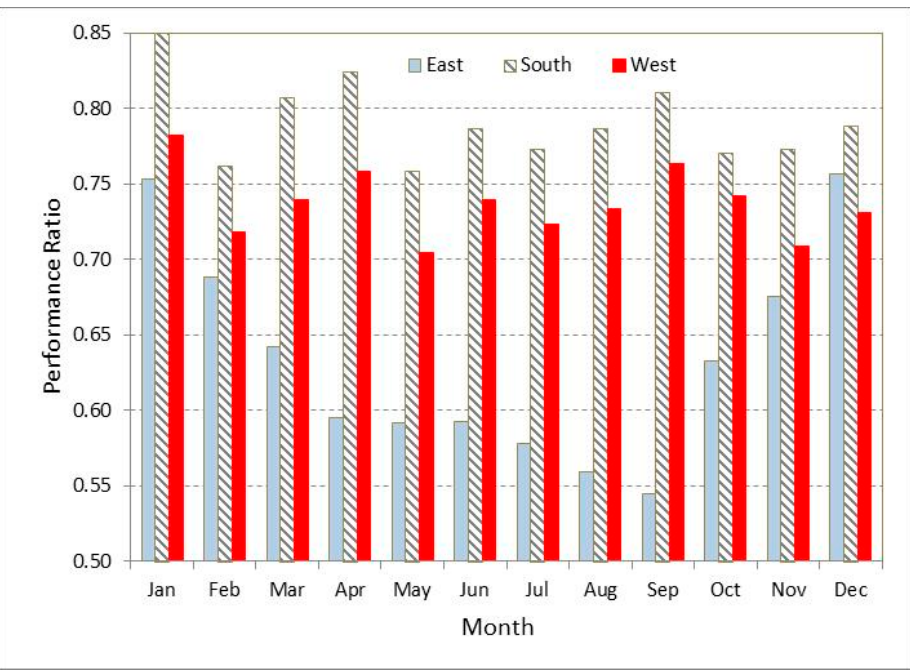
Figure 8. Final Yield of each façade and of the total PV installation, in hours (kWh/kWp).